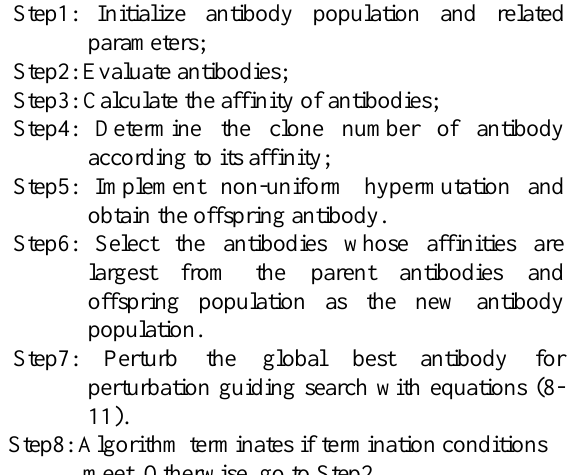
Fig. 2. Algorithmic